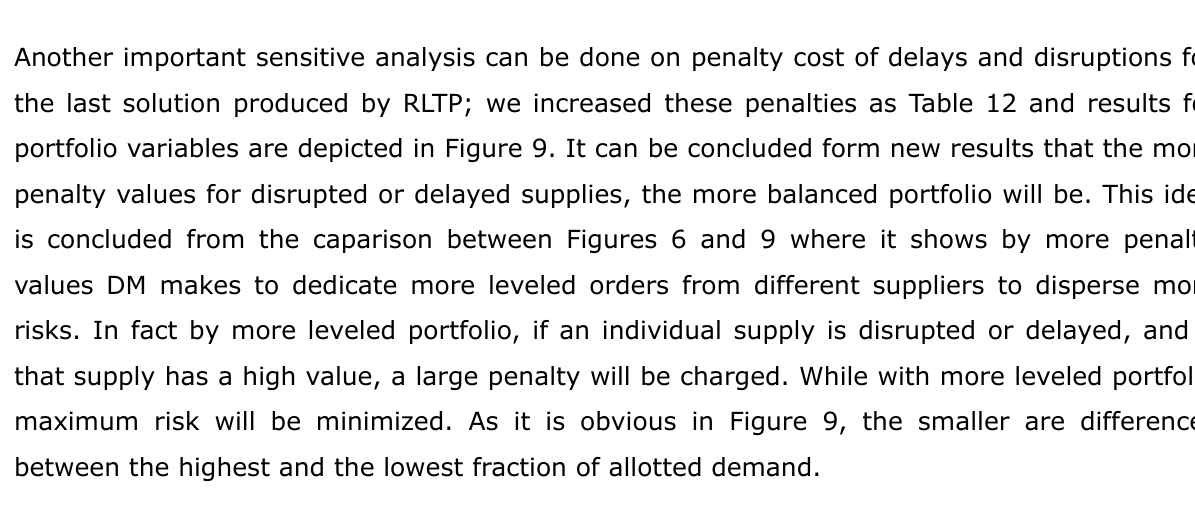
Figure 7. Supply portfolio for α=75% with an increase in delay and disruption